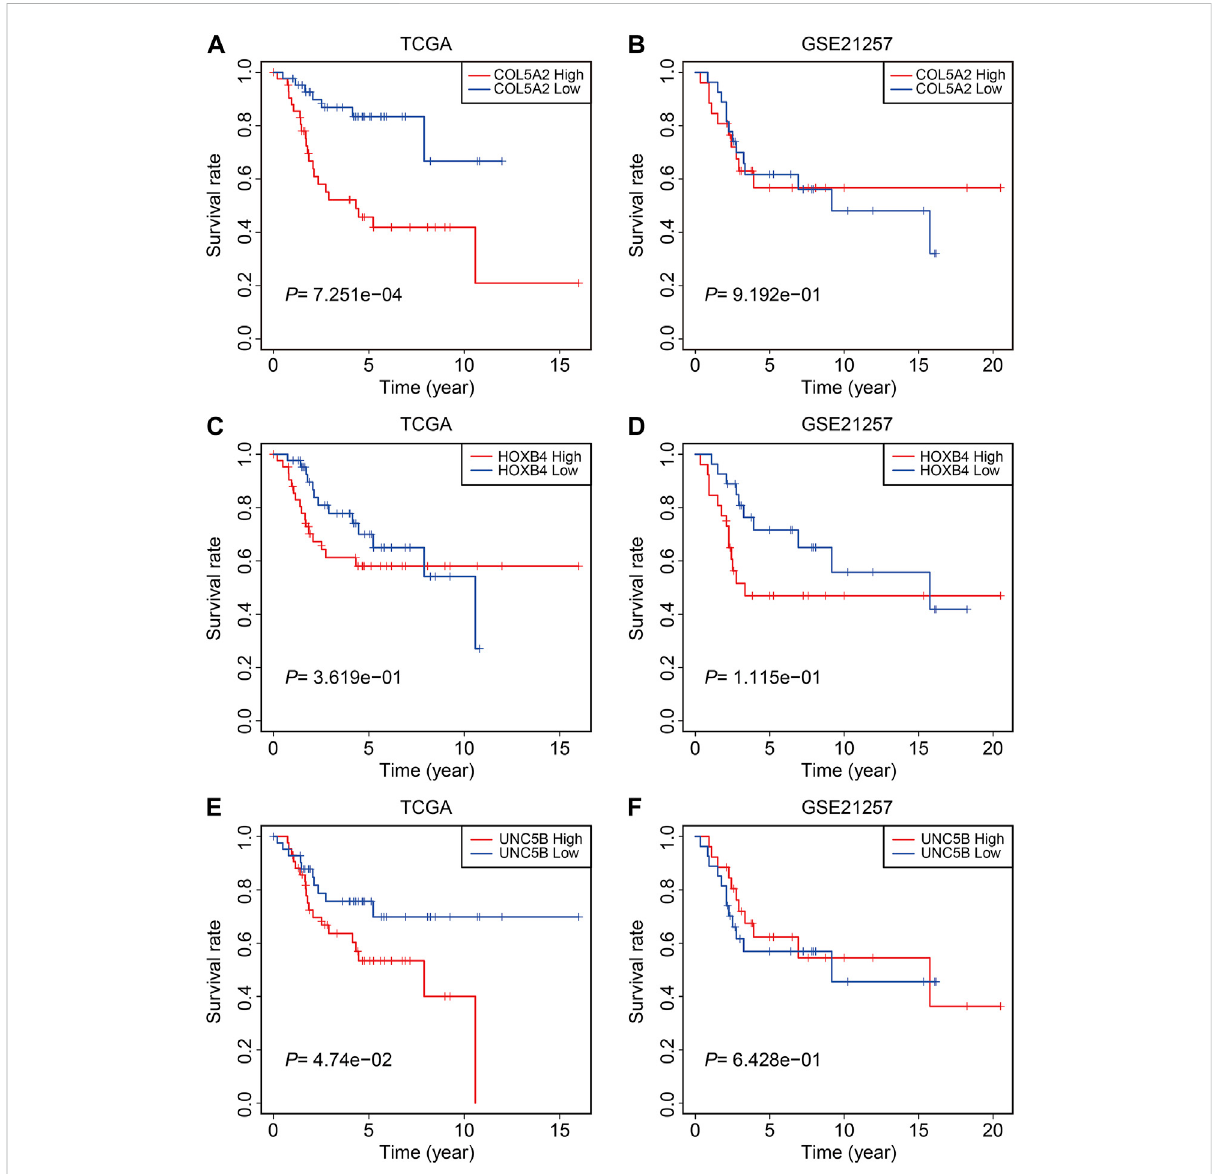
FIGURE 11 Kaplan – Meier survival analysis of COL5A2 (A,B) , HOXB4 (C,D) , and UNC5B (E,F) in TCGA and GSE21257